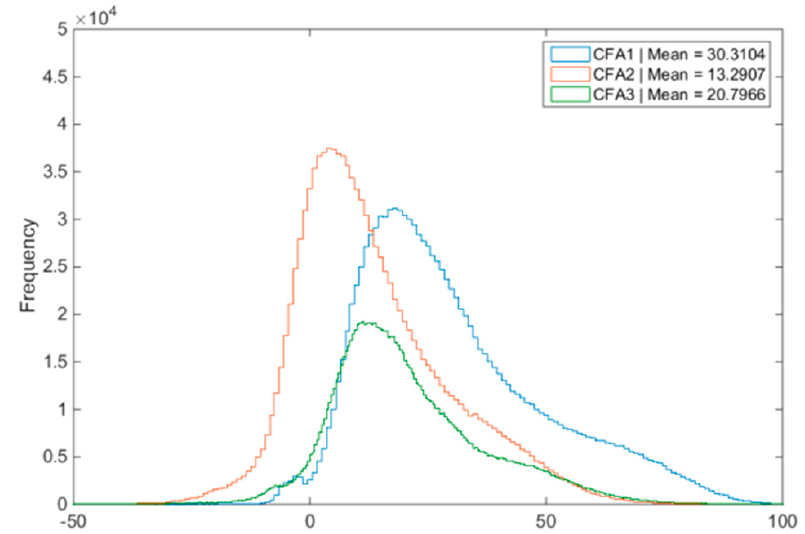
Figure 23. No denoising cases at 10 dBs. Error distributions of the three CFAs.